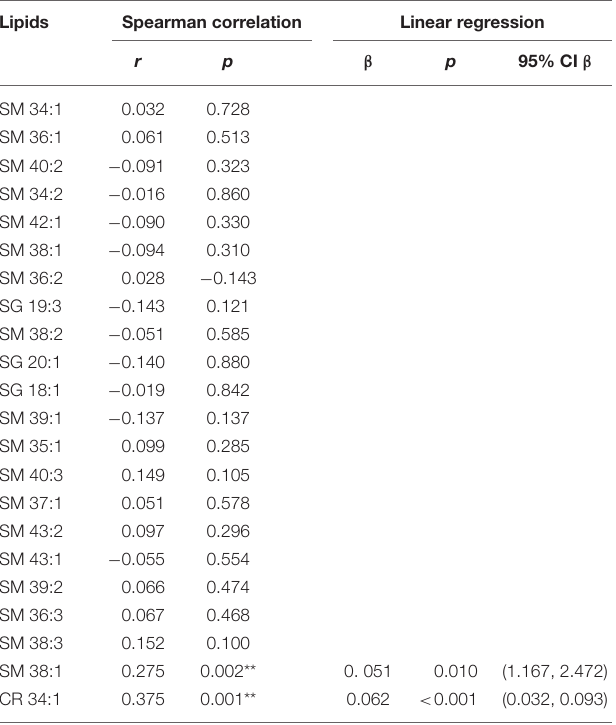
TABLE 4 | Lipid screening analysis in ASPIRE cohort. Lipids Spearman correlation Linear regression